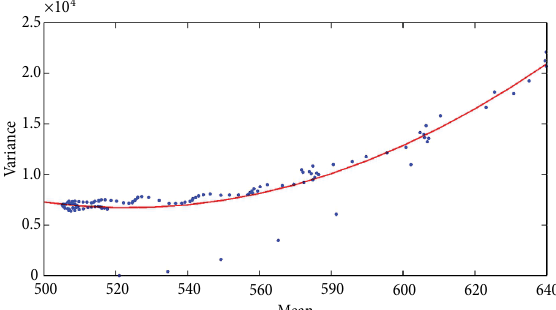
Figure 2. Mean–variance